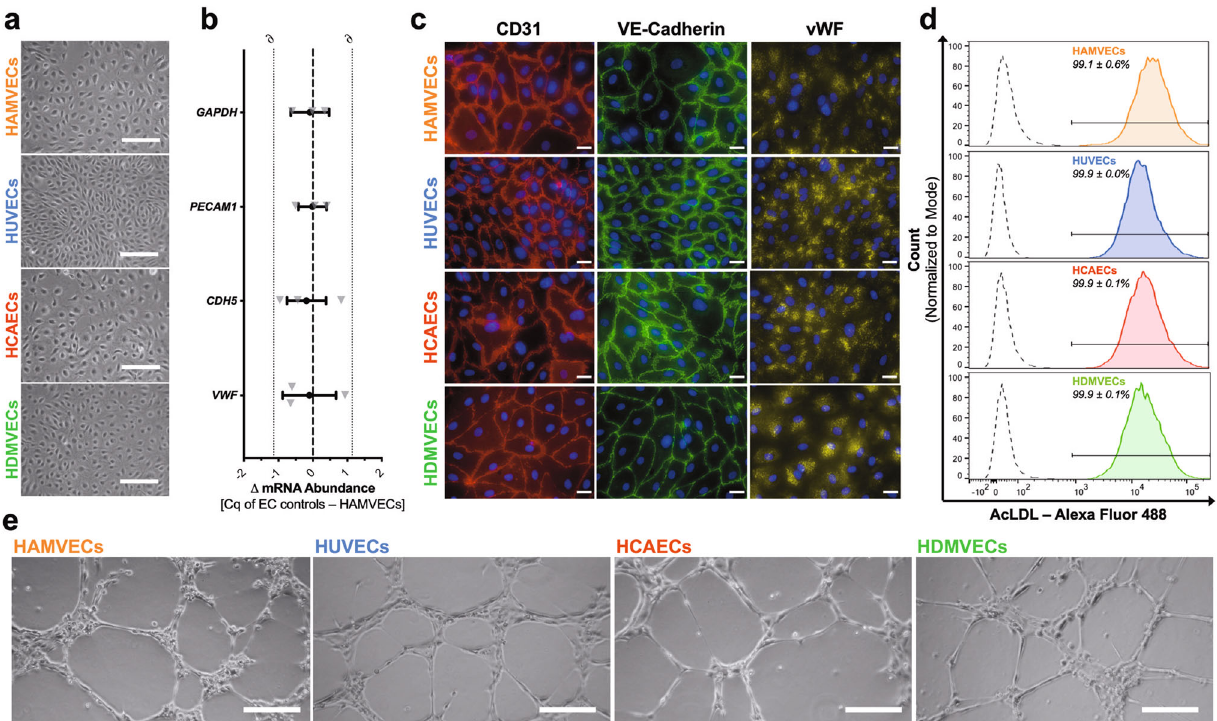
Fig. 2 Human adipose tissue-derived microvascular endothelial cells (HAMVECs) exhibit morphological, molecular, and functional hallmarks of endothelium. HAMVECs were compared with endothelial cell (EC) controls representative of the predominant endothelial specializations, namely human umbilical vein ECs (HUVECs; macrovascular, venous endothelium), human coronary artery ECs (HCAECs; macrovascular, arterial endothelium), and human dermal microvascular ECs (HDMVECs; microvascular endothelium). a Cobblestone-like morphology of endothelium. Scale bars represent 200 µ m. b Abundance of transcripts encoding CD31 (gene: PECAM1 ), vascular endothelial (VE)-cadherin (gene: CDH5 ), and von Willebrand Factor (vWF; gene: VWF ). Glyceraldehyde-3-phosphate dehydrogenase (gene: GAPDH ) was used as a loading control. Dashed line depicts a mean difference of zero; and dotted lines is the equivalence margin ( ∂ ) used for the two one-sided test for equivalence. Values represent the mean ± 90% con fi dence interval; mRNA, messenger ribonucleic acid; and C q , the quanti fi cation cycle. c Expression and localization of the corresponding endothelial proteins. Scale bars represent 25 µ m. d Internalization of acetylated low-density lipoprotein (AcLDL). Solid and dashed lines represent ECs cultured in the presence and absence of Alexa Fluor 488-conjugated AcLDL, respectively. Values represent mean ± standard deviation. e Capillary-like tubulogenesis by ECs. Scale bars represent 200 µ m. All experiments were performed in biological triplicate, using cells derived from three different donors ( n = 3 biologically independent